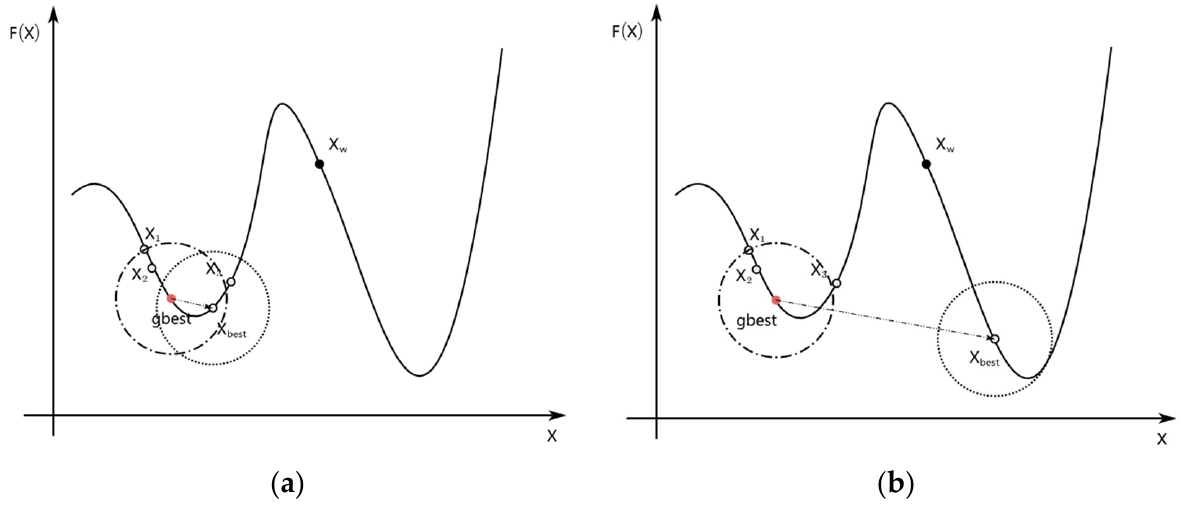
Figure 4. Different situations caused by update operation. ( a ) Premature convergence caused by updating gbest. ( b ) Jump out of local optima by updating gbest . To make full use of the advantages of elite individuals and avoid premature conver- gence, this paper proposed an elite learning mechanism based on Euclidean distance. Here, the elite individual is denoted as gbest . In the first generation, the individual with the best fitness is selected as gbest . Figure 5 is the landscape of a two-dimensional optimization problem. Figure 6 shows the different situations for triggering the update operation. In Figure 6, gbest (the red pentagram) is the historical optimum solution. Blue squares and black triangles represent better and worse individuals, respectively. R is the average of the distance between the elite individuals and the gbest . A and B are the optimal solutions of the current generation, which may be used to update gbest . If the optimum solution A (the red quadrangle) obtained in the current generation falls into the circle, the update operation is not triggered to avoid the population falling into local optimization. On the contrary, if the optimum solution B (the red quadrangle) obtained in the current generation falls outside the circle, the update operation is triggered to guide the population to explore a more promising region.